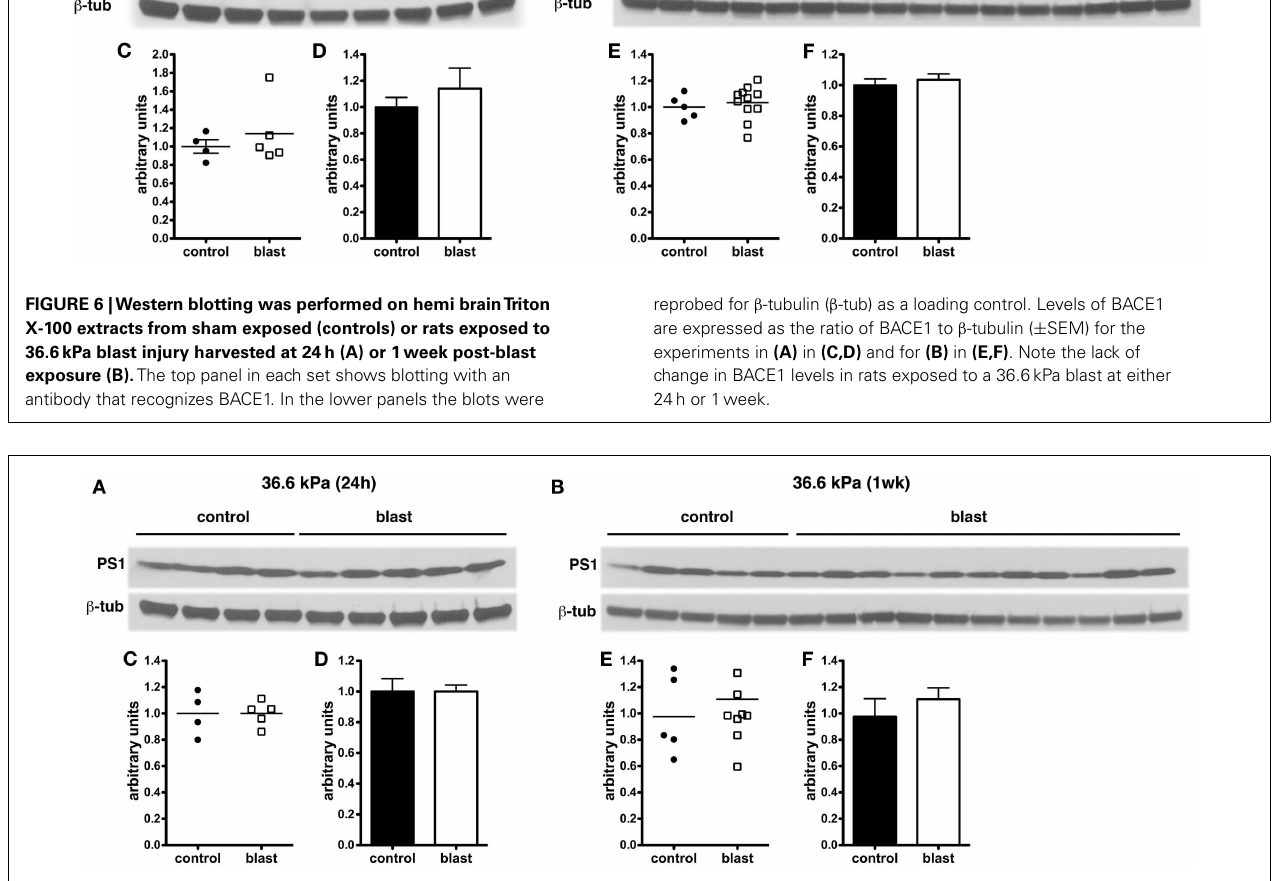
were reprobed for β -tubulin ( β -tub). Levels of presenilin-1 are expressed as the ratio of presenilin-1 to β -tubulin ( ± SEM) for the experiments in (A) in (C,D) and for (B) in (E,F) . Note the lack of change in PS1 levels in rats exposed to a 36.6kPa blast at either 24h or 1week.